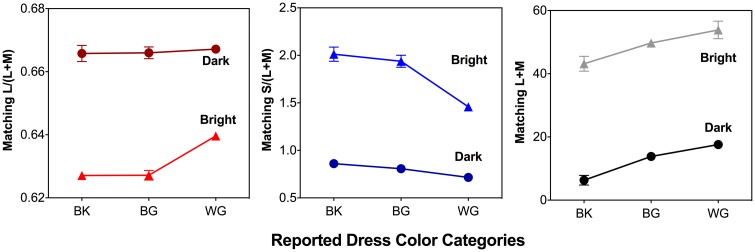
Group mean color matching to #TheDress results: Mean L/(L+M) (left panel), S/(L+M) (middle panel) and (L+M) (right panel) matching results for the bright (triangles) and dark (circles) regions of the dress image. The unit for luminance (L+M) is cd/m2. There is no unit for L/(L+M) or S/(L+M). Error bars are ±SEM. For the bright region, WG observer group had higher L/(L+M) and lower S/(L+M) compared to BG or BK observer groups. For the dark region, the three observer groups did not differ in L/(L+M), while the WG observer group had lower S/(L+M) compared to BK observer group. For both bright and dark regions of the dress, the matching luminance (L+M) was significantly different among the BK, BG, and WG groups. BK: blue-and-black; BG: blue-and-gold; WG: white-and-gold.